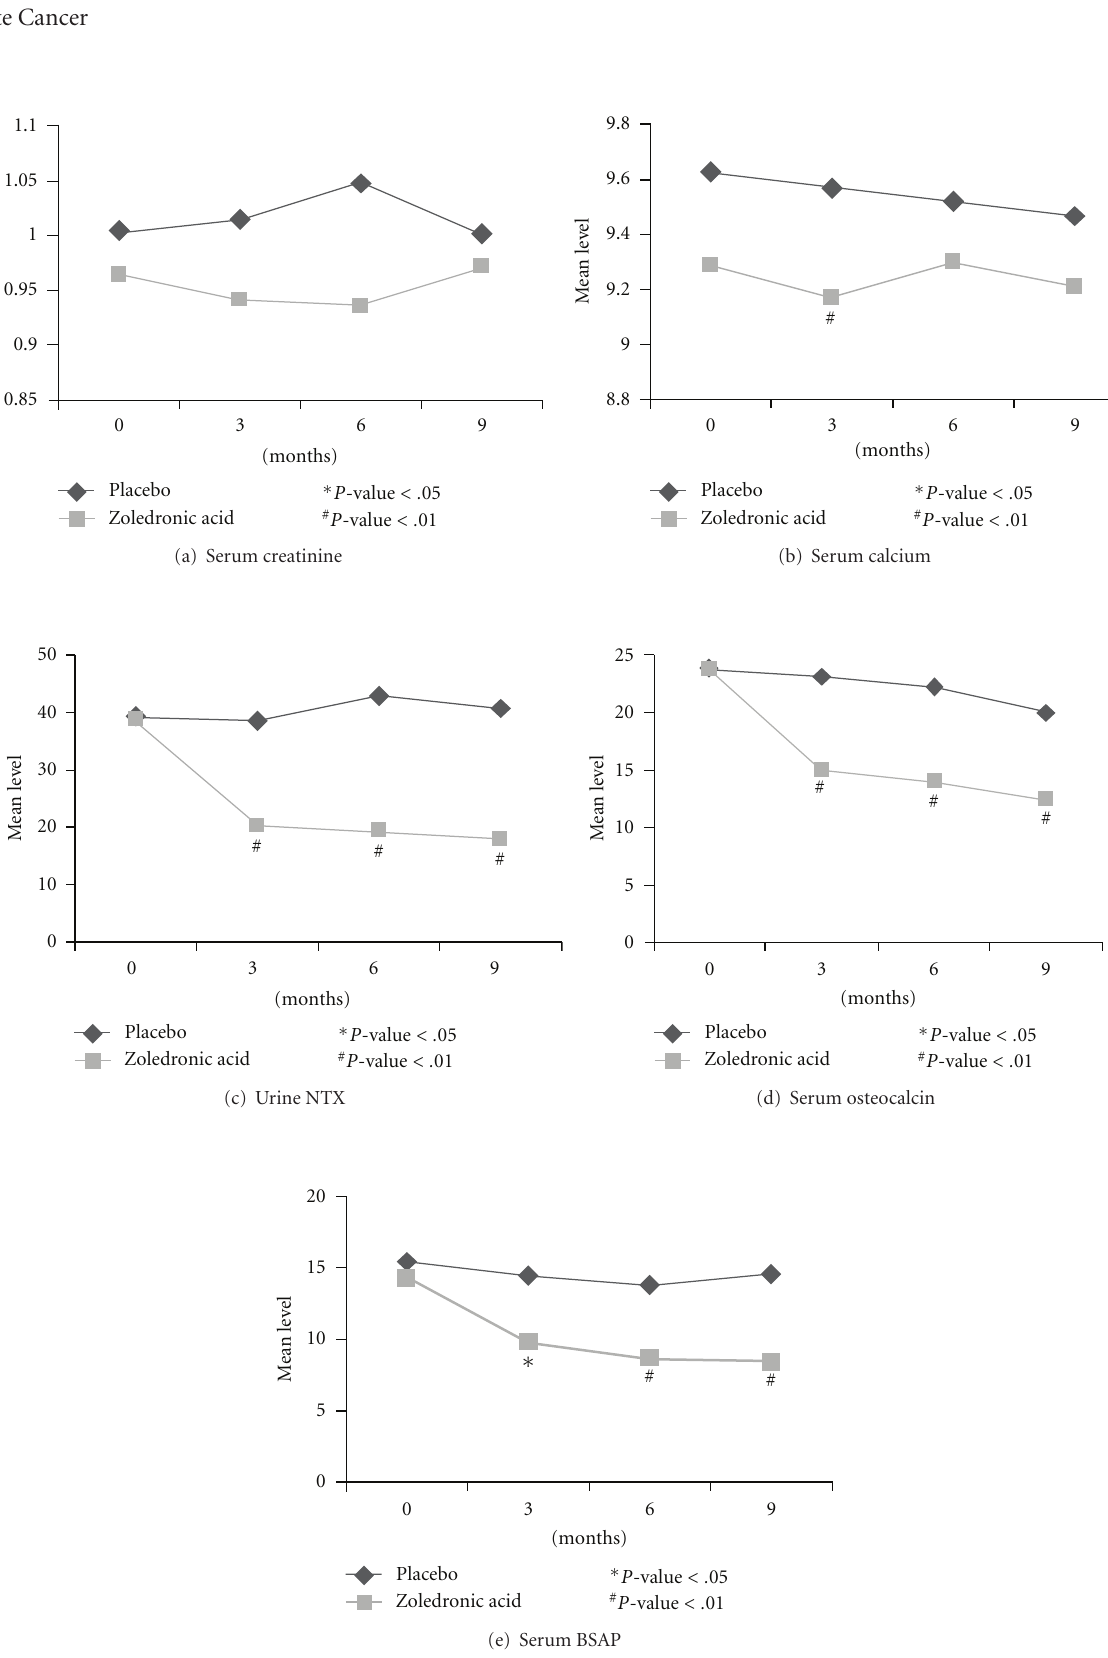
Figure 2: Comparison of biomarker levels between that two groups at each time